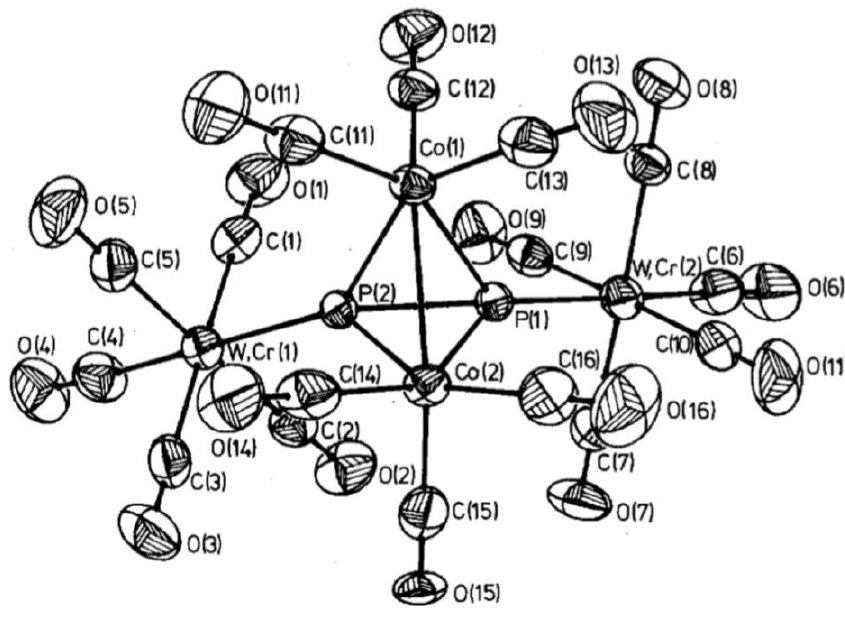
Figure 17. X-ray structure of complex 28 [73]. Catalysts 2018 , 8 , x FOR PEER REVIEW